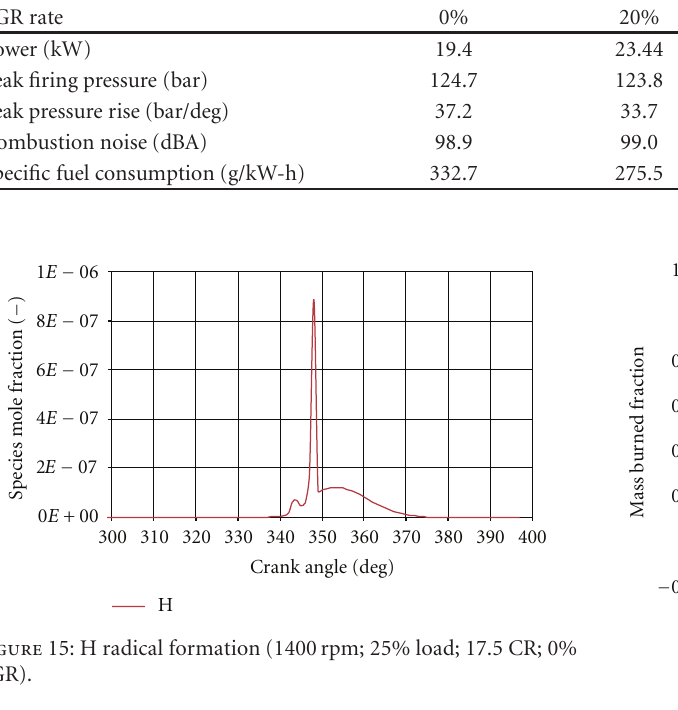
Figure 17: E ff ect of EGR on mass burned fraction (1400rpm; 25% load; 17.5